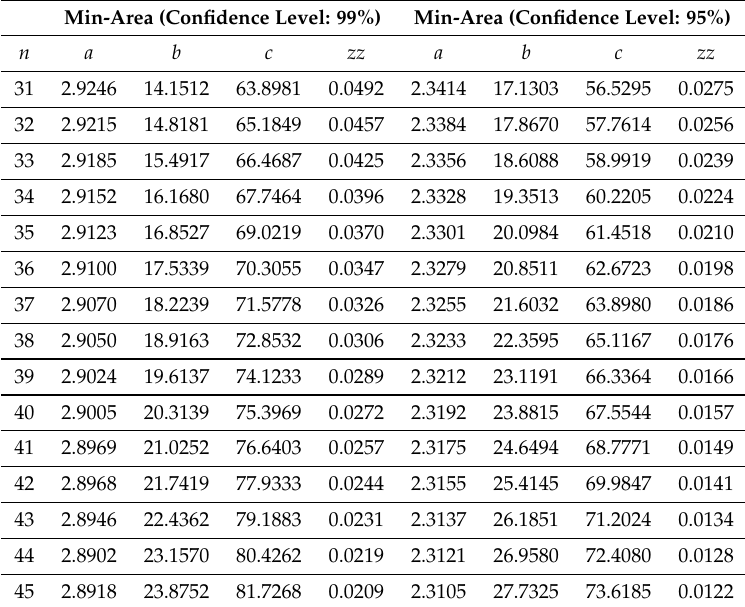
Table 3. Minimizing area method (confidence level is 99% and 95%).